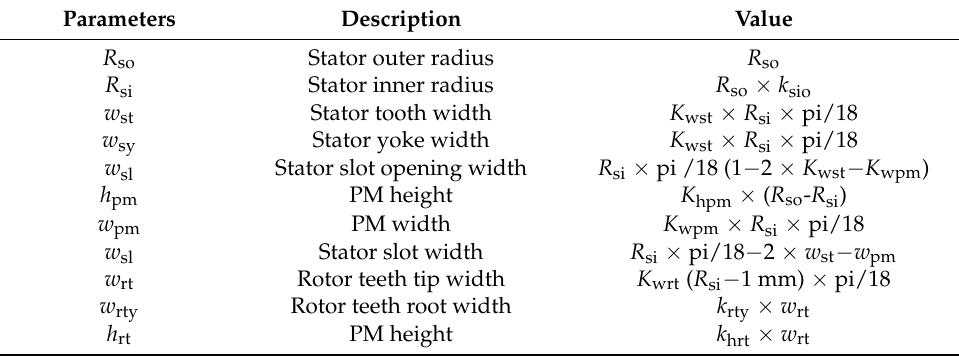
Table 2. Initial design parameters of the FSPM